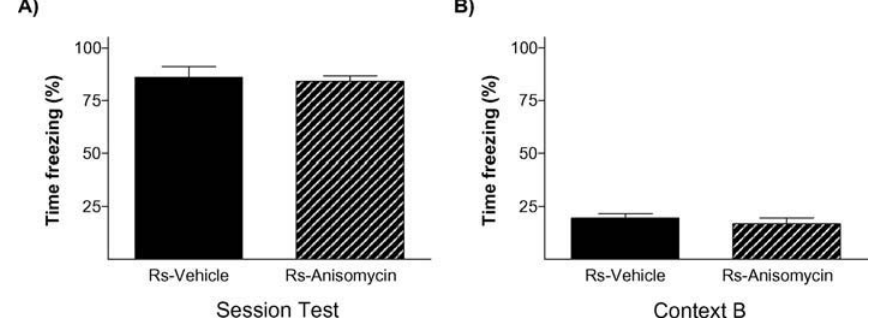
Figure 7. Emotional memory of stressed rats for the contextual fear conditioning test was not affected by anisomycin treatment. The graphs show the percent time stress rats froze during the test of the CFC on day 9 when they were exposed to (A) the same context they were conditioned (context A) or (B) a new context 2hours after being tested for fear conditioning in context A. No differences were observed between groups (solid bars, vehicle; hatched bars,